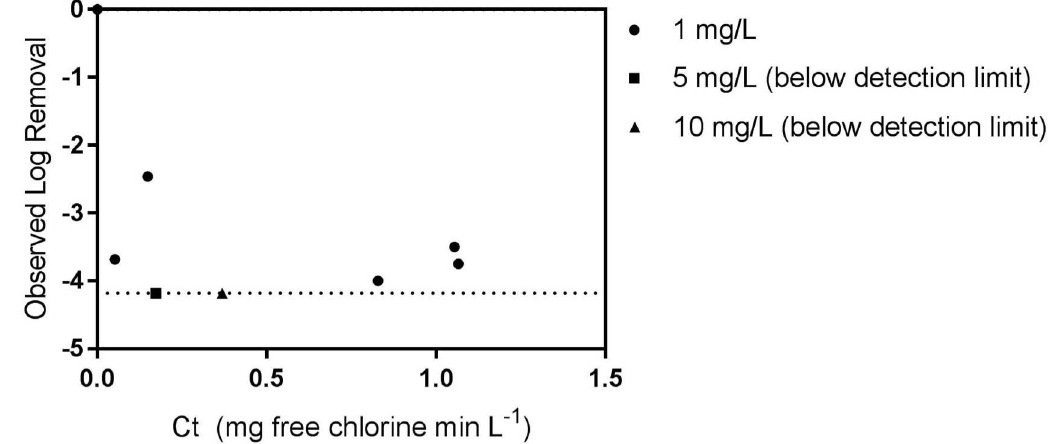
Fig 3. Log viral removal versus estimatedCt. Viral removal for 5 and 10 mg L -1 chlorineconditions shown at detection limit for demonstration purposes. Dashedline representslimit of detection. The limit of detectionwas 0.75 log TCID 50 mL -1 , resulting in a maximum observable log 10 TCID 50 removalof 4.18 TCID 50 mL -1